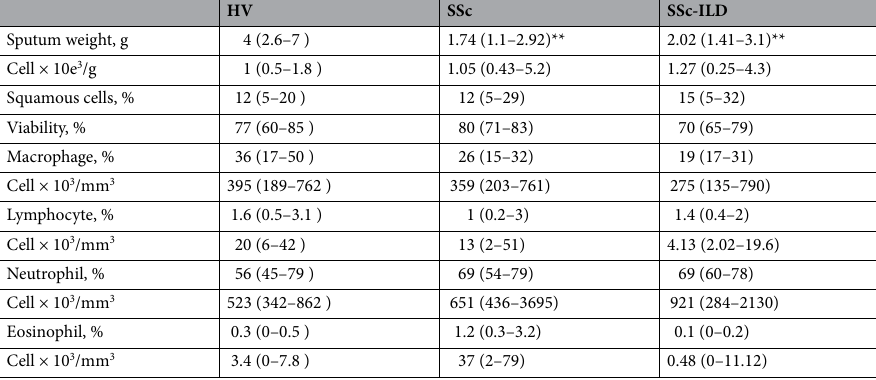
Table 2. Sputum cell counts. Results are expressed as median (min–max). **p <